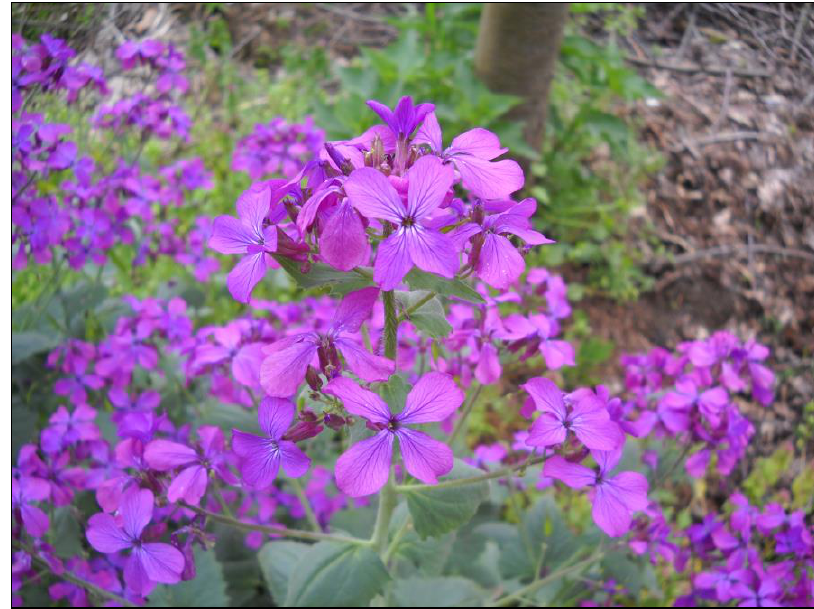
Figure 1. Lunaria annua L. (Brassicaceae) aerial part (Photo: J. S. Katanić Stanković, April